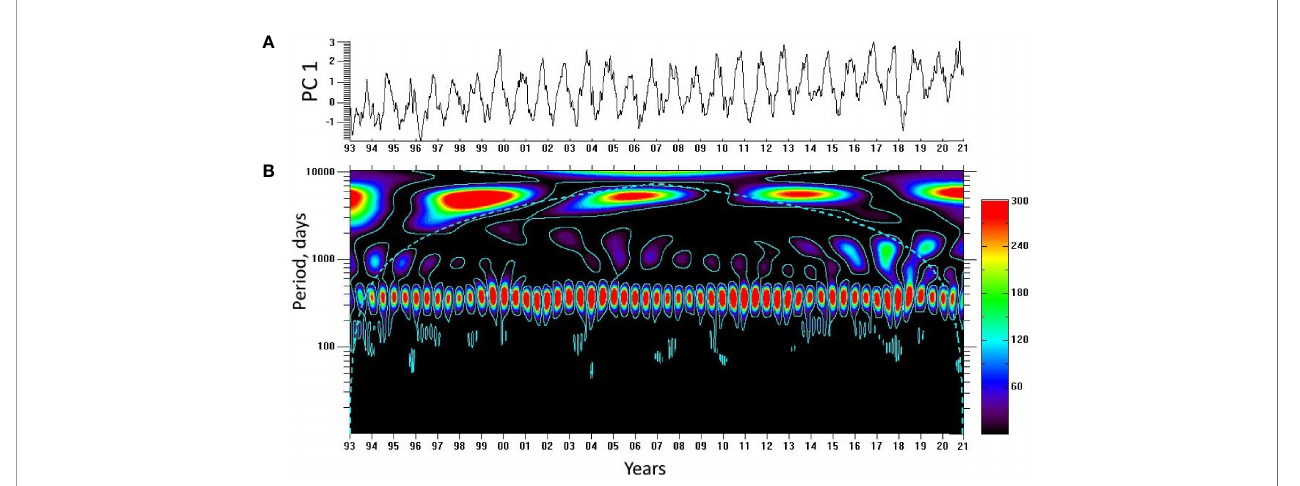
FIGURE 3 | (A) The principal component PC 1 (dimensionless) for the northern JES and (B) its WT